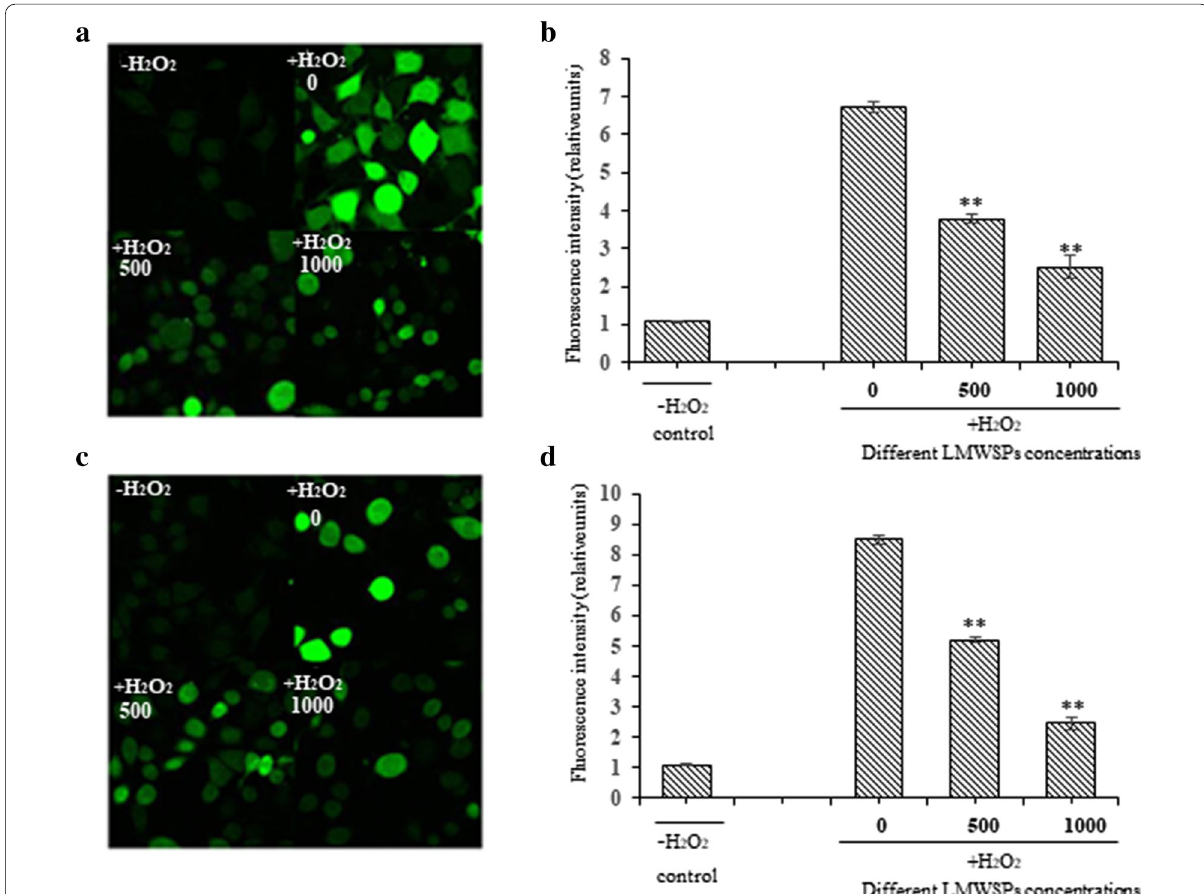
Fig. 4 Protective effect of LMWSPs on L02 cells impaired by H 2 O 2 . a ROS level was determined by measuring the fluorescence of L02 cells under a confocal microscope. a: Wt; b: 2000 H 2 O 2 0 peptides; c: 2000 H 2 O 2 500 μg/mL peptides; d: 2000 H 2 O 2 1000 μg/mL peptides. b Quantification + + + of intracellular ROS production in damaged and normal cells. Data are expressed as mean SE, n 3, ** P < 0.01 (compared with H 2 O 2 control ± = group). c NO level was determined by measuring the fluorescence of L02 cells under a confocal microscope. a: Wt; b: 2000 H 2 O 2 0 peptides; c: + 2000 H 2 O 2 500 μg/mL peptides; d: 2000 H 2 O 2 1000 μg/mL peptides. d Quantification of intracellular NO production in damaged and normal + + cells. Data are expressed as mean SE, n 3, ** P < 0.01 (compared with H 2 O 2 control ± =